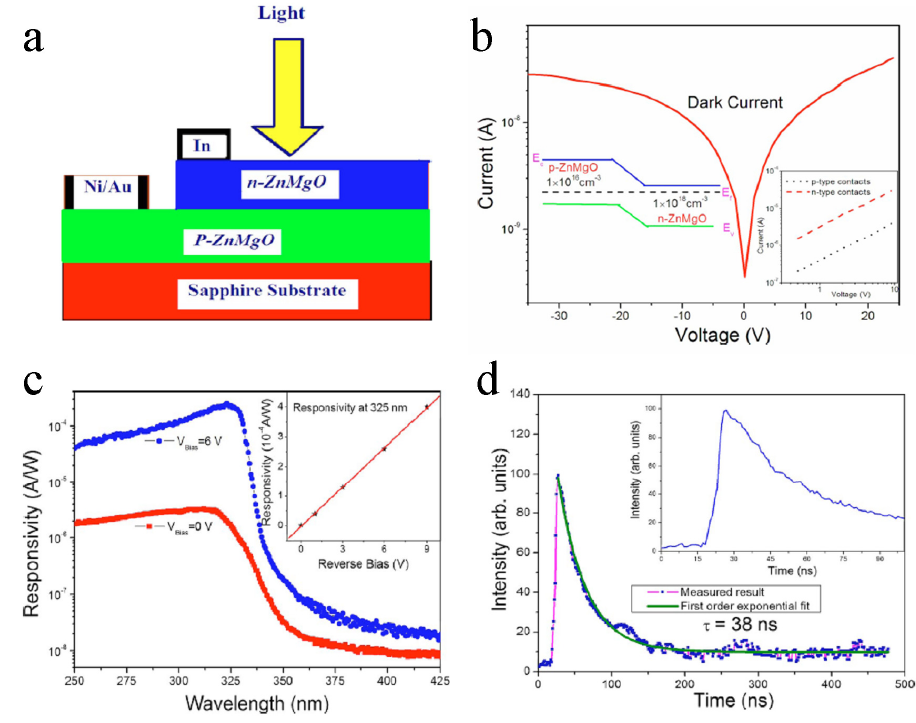
homojunction diode in dark. The left inset gives the energy band diagram at